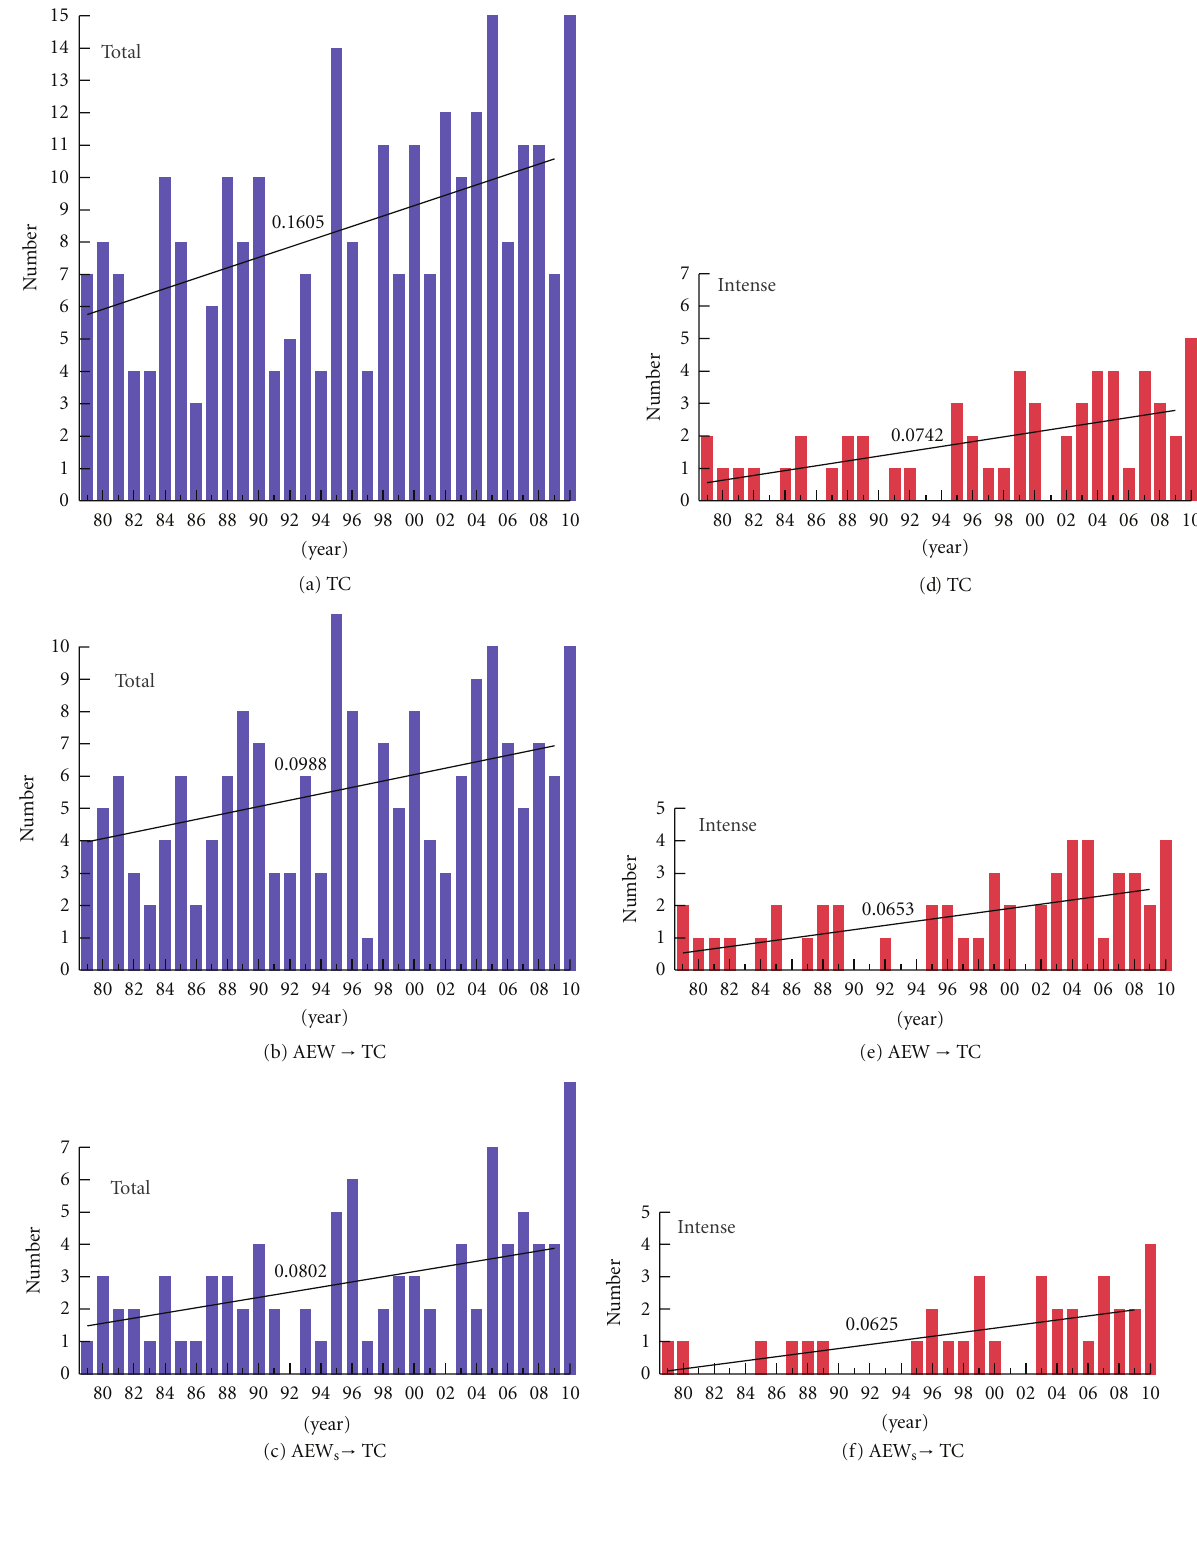
Figure 9: Number of Atlantic tropical cyclones (TCs) during July–September, for (a) total TCs, (b) AEW-induced TCs, and (c) southern- track AEW-induced TCs. (d)–(f) same as (a)–(c) but for intense TCs of Category 3 and above. The linear trends and slopes are given. All trends are significant at the 95% confidence interval per t